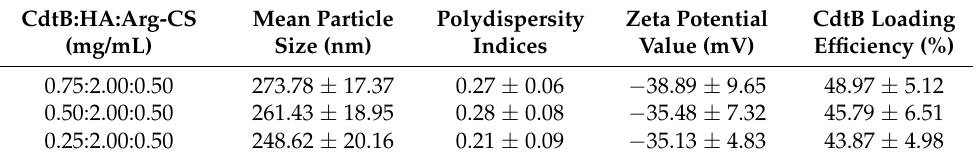
Table 2. Characteristics of HA-NPs encapsulating varying CdtB